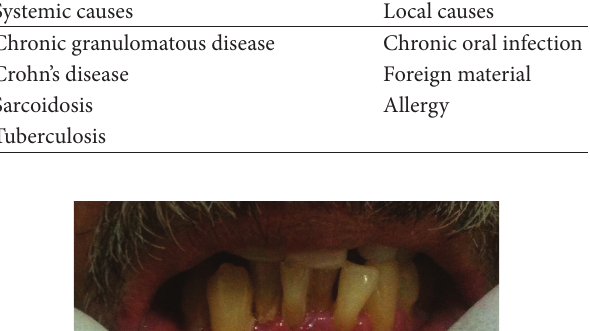
Figure 2: Aggregates of noncaseating granulomas (H&E 10x).